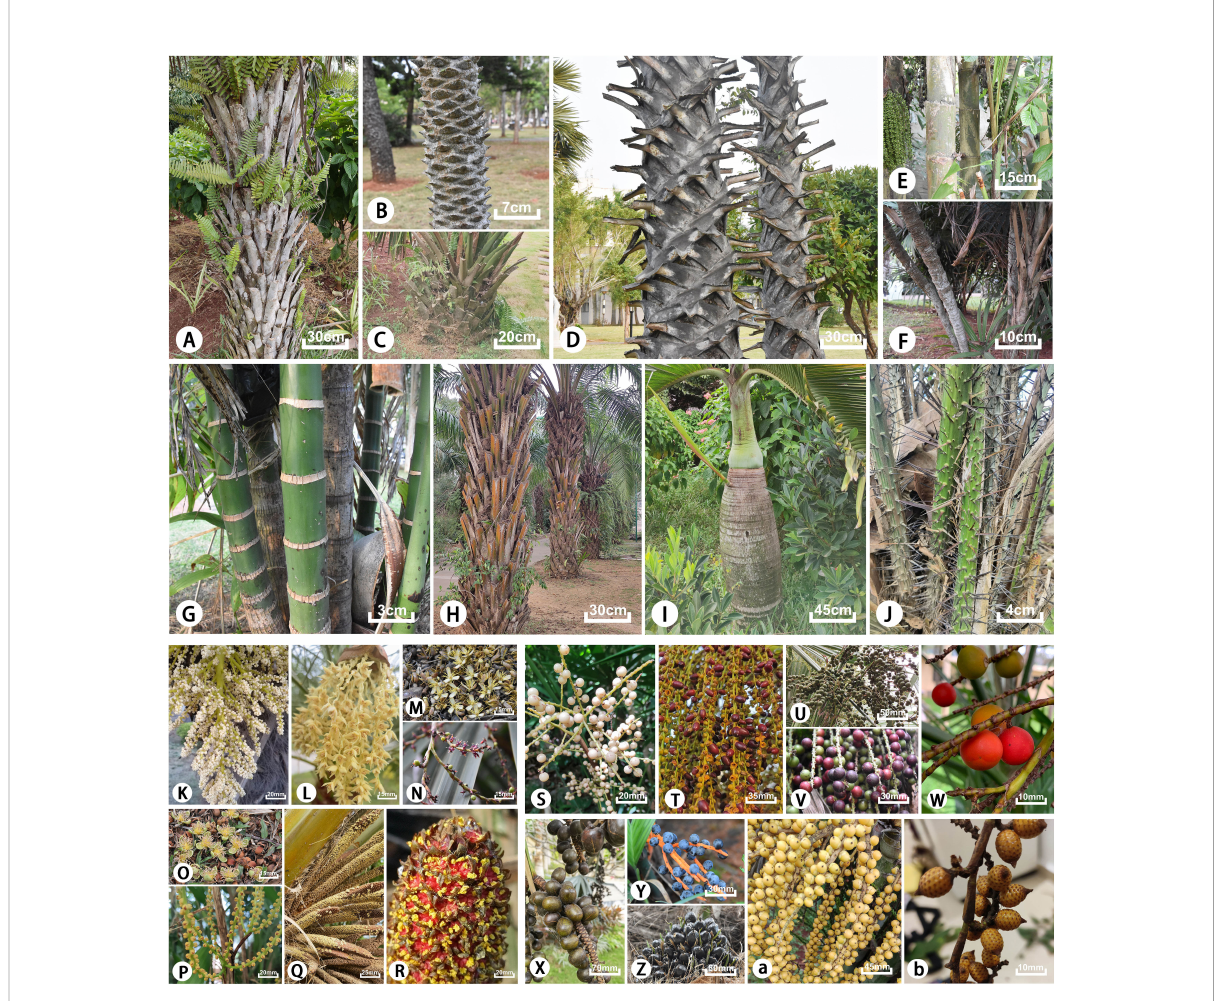
FIGURE 1 Typical morphological characteristics of tribes of the subfamilies in Arecacea. Coryphoideae: (A) Copernicia alba ; (B, L, T) Phoenix roebelenii ; (C, U) Sabal minor ; (D) Borassus fl abellifer ; (E, M, V) Caryota mitis ; (F, N, W) Chuniophoenix hainanensis ; (K) Trachycarpus fortunei ; (S) Lanonia dasyantha ; (X) Bismarckia nobilis ; Arecoideae: (G) Areca triandra ; (H, Q, Z) Elaeis guineensis ; (I) Hyophorbe lagenicaulis ; (O) Wodyetia bifurcata ; (P, Y) Chamaedorea elegans ; (a) Ptychosperma macarthurii ; Calamoideae: (J, R) Salacca zalacca ; (b) Calamus rhabdocladus